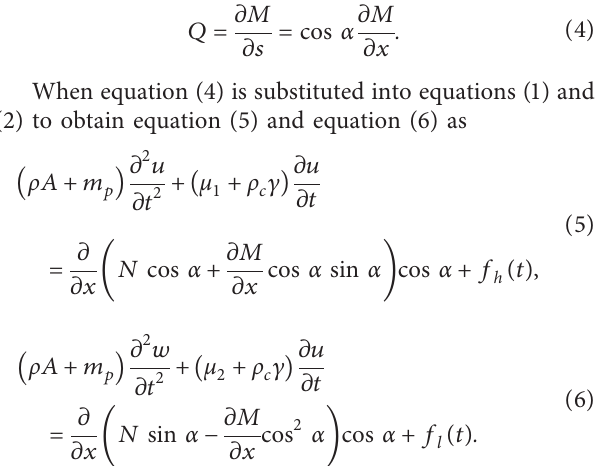
Figure 2: Force analysis on beam and micro-segment under longitudinal and lateral loading by